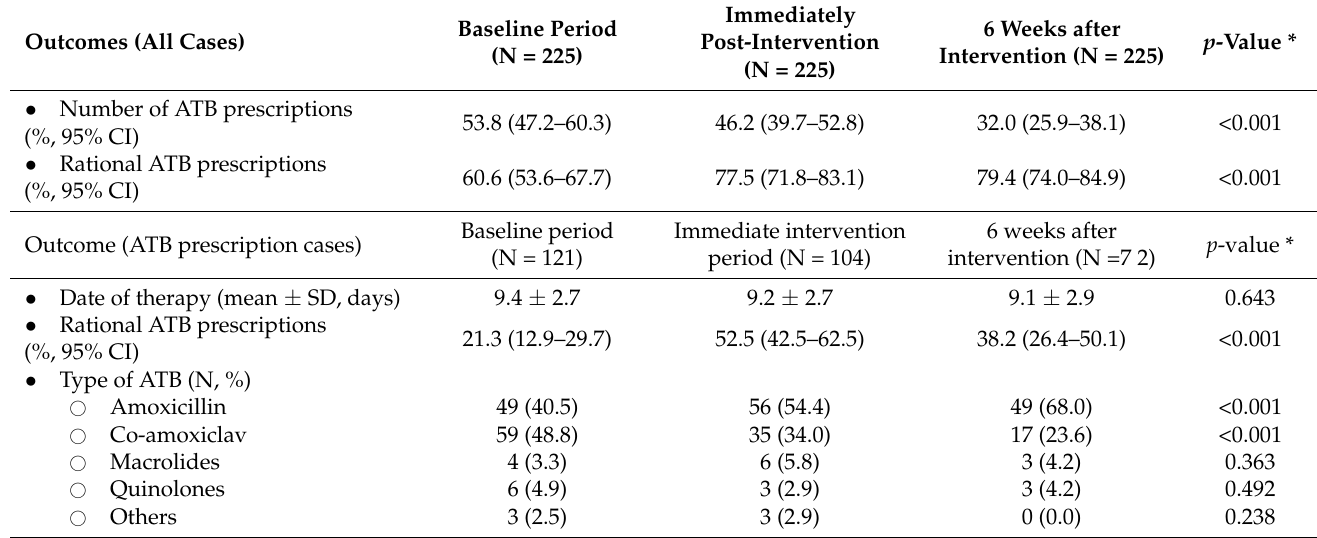
Table 2. Antibiotic prescription and its rationale at baseline and intervention periods.